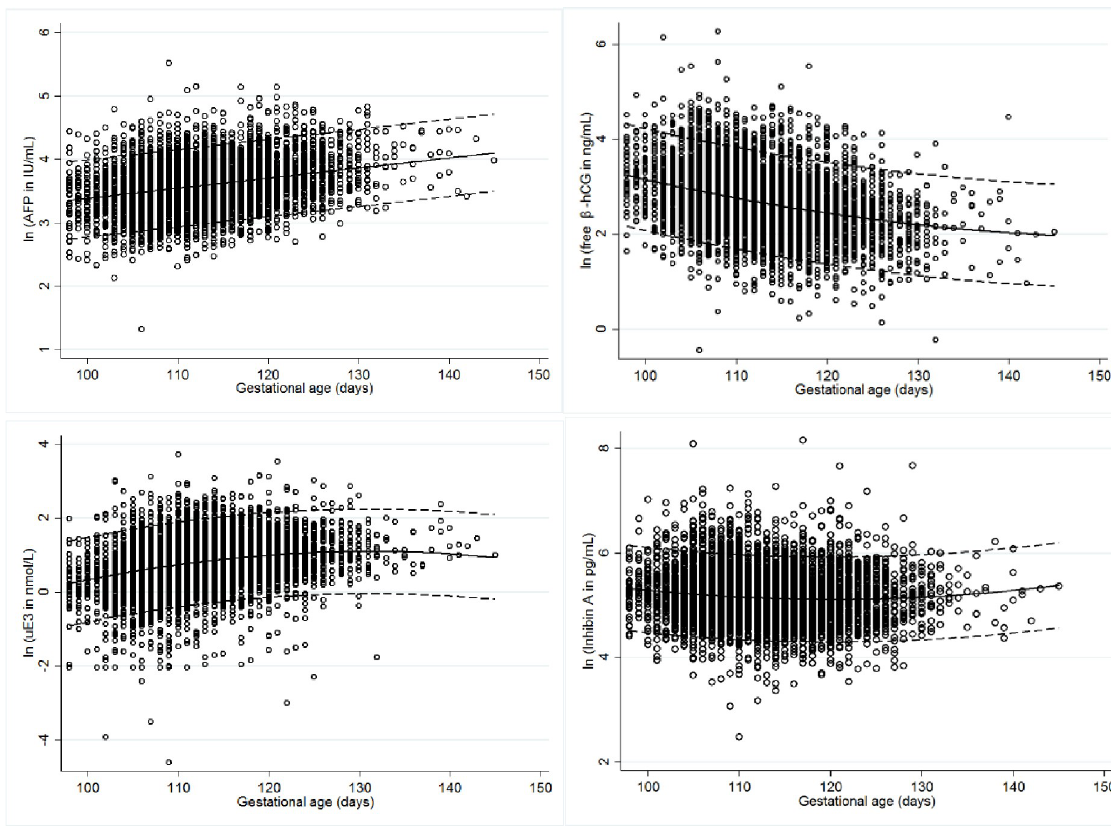
Fig 2. Scatter plots of the log regression of median levels of AFP, free β -hCG, unconjugated estriol (uE3) and inhibin A according to gestational age by days of normal fetuses. The straight lines show the tendency of the regression line across gestational age at the 5th, 50th and 95th